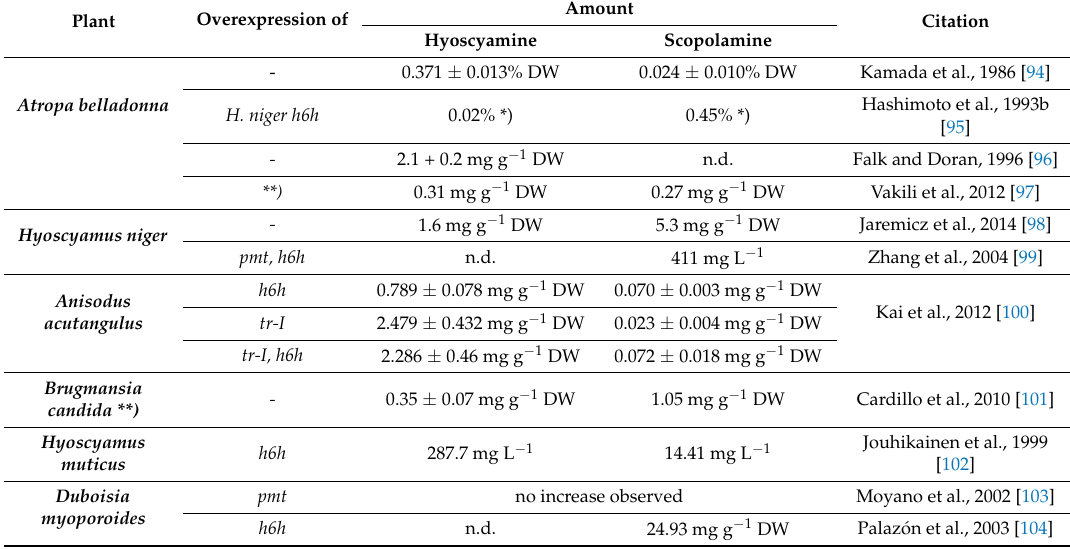
Table 1. Overview of TA concentrations in engineered and untreated hairy cultures from different plants. TAs content in leaves of regenerated plants; n.d. = not determined, DW = dry weight.